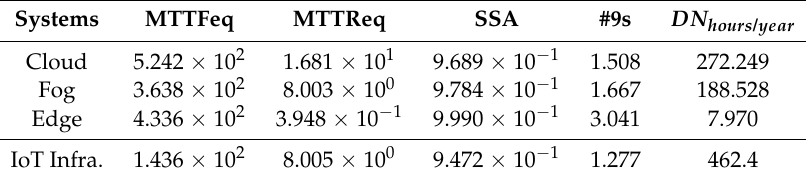
Table 4. Steady state analysis of IoT infrastructure under default